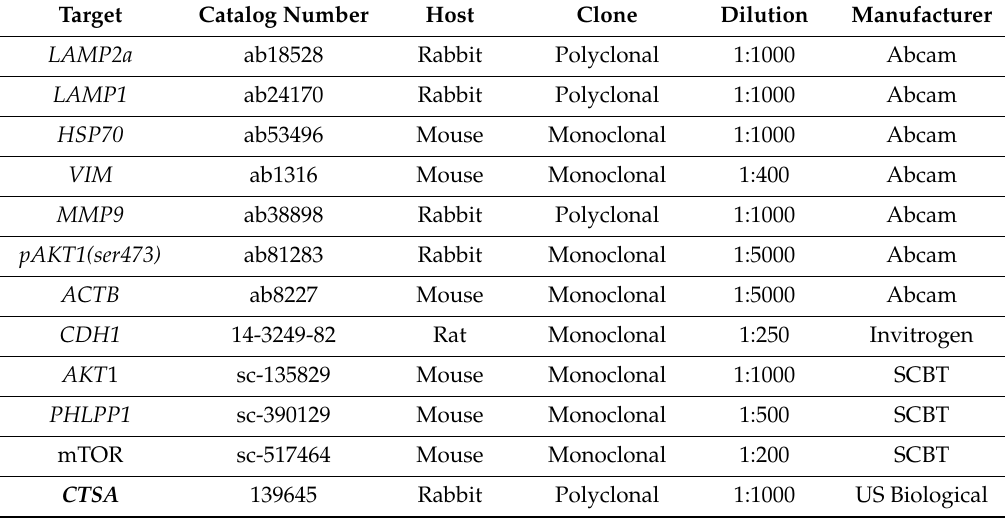
Table 1. Antibodies used in this